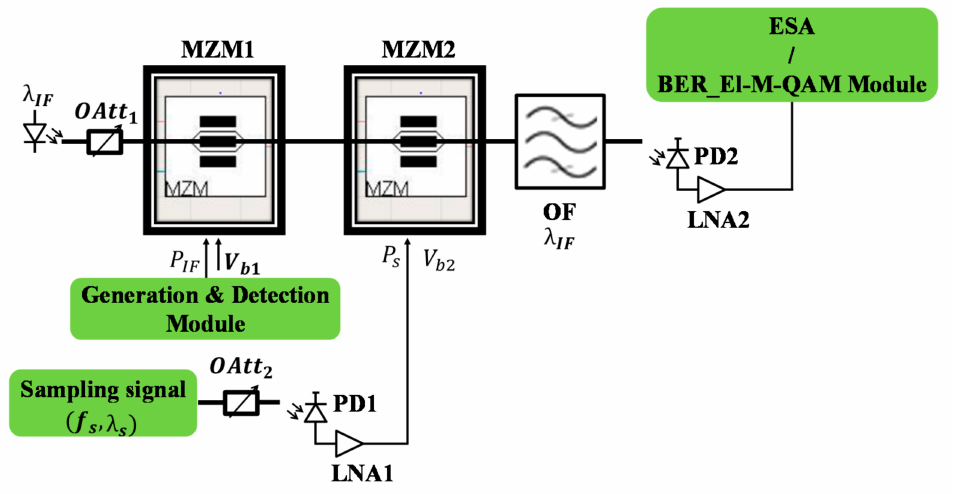
Figure 5. Simulation setup for electro-optical mixing using a cascaded MZMs link. OAtt: Optical Attenuator, LNA: Low Noise Amplifier, MZM: Mach–Zehnder Modulator, QAM: Quadrature